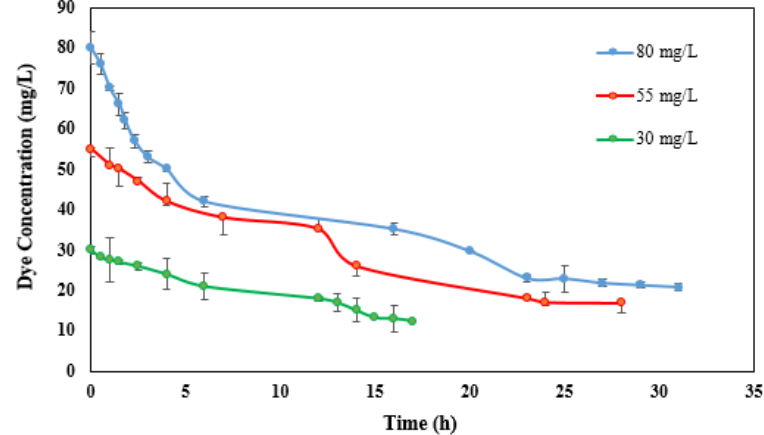
Figure 7. Time course for decolorization of RB221 at different dye concentrations by CNT-modified cathode and free laccase in cathode compartment of MFC.